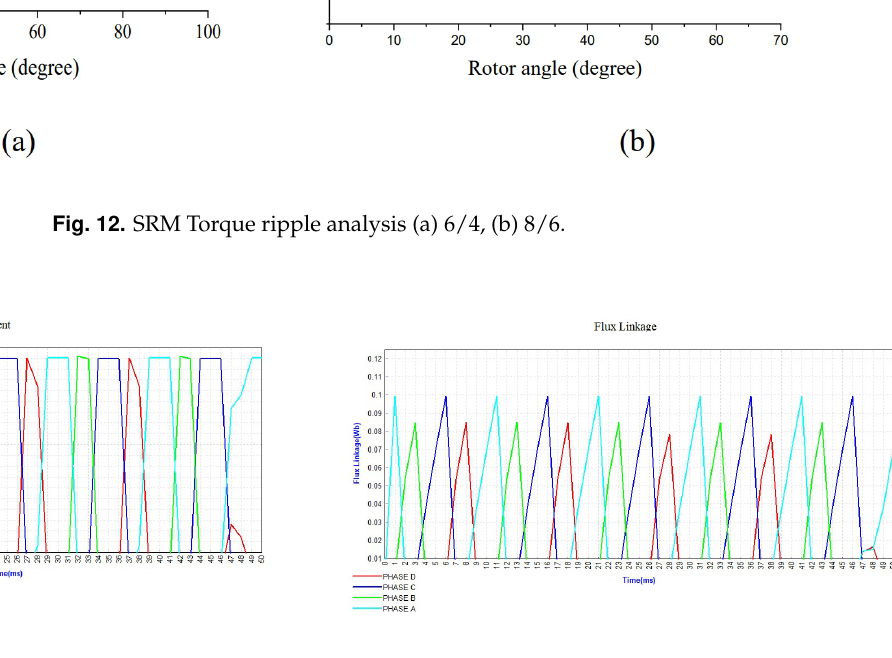
Fig. 13. 8/6 SRM Phase Current. Fig. 14. 8/6 SRM flux